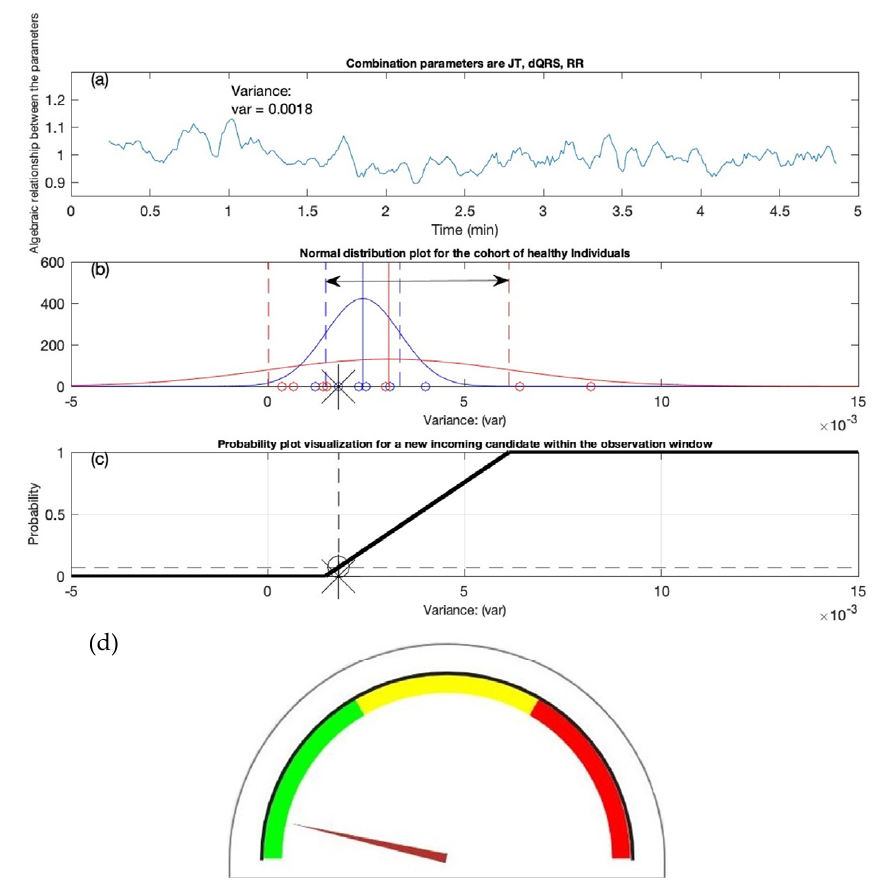
Figure 6. Test candidate #1. ( a ) The algebraic relation is shown for the combination of JT, RR, and QRS intervals. ( b ) The classification of the candidate is marked with an asterisk indicator. ( c ) The decision support system recommends the probability of the AF equal to 0.07. ( d ) The semi-gauge representation is exhibited for the candidate with the arrow of the gauge pointing towards green, indicating that the person is classified as a healthy individual.